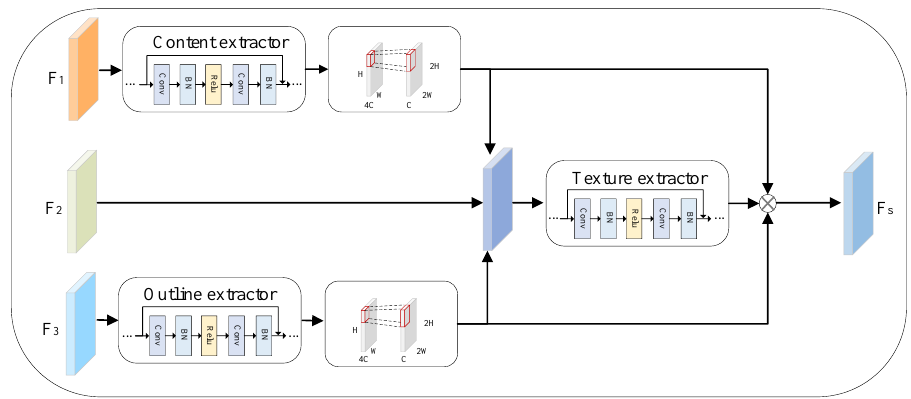
Figure 2. The architecture of image super-resolution (SR) network. F 1 denotes the content input, F 2 denotes the texture input, and F 3 denotes the outline